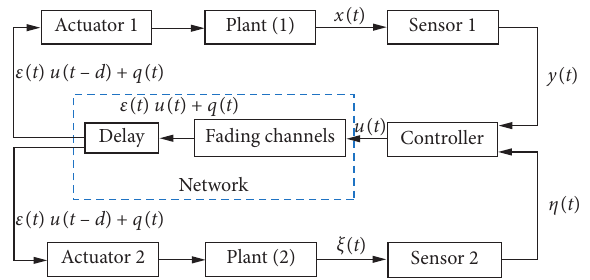
Figure 1: NCS over delayed and fading noisy